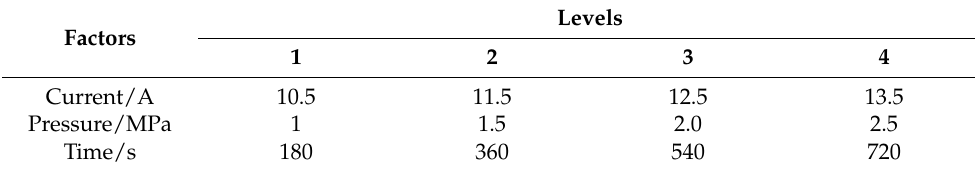
Table 4. Factors and levels.